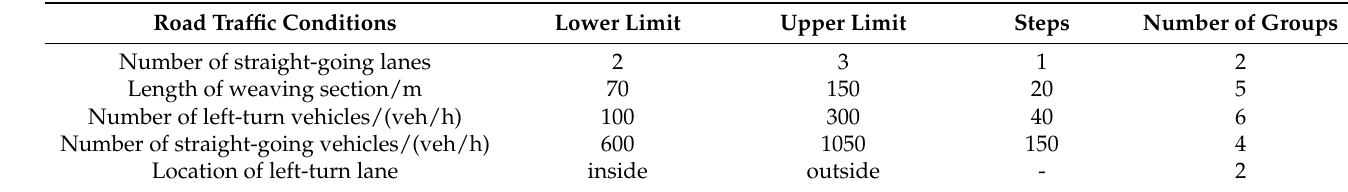
Table 3. The road traffic parameters of simulation experiment.